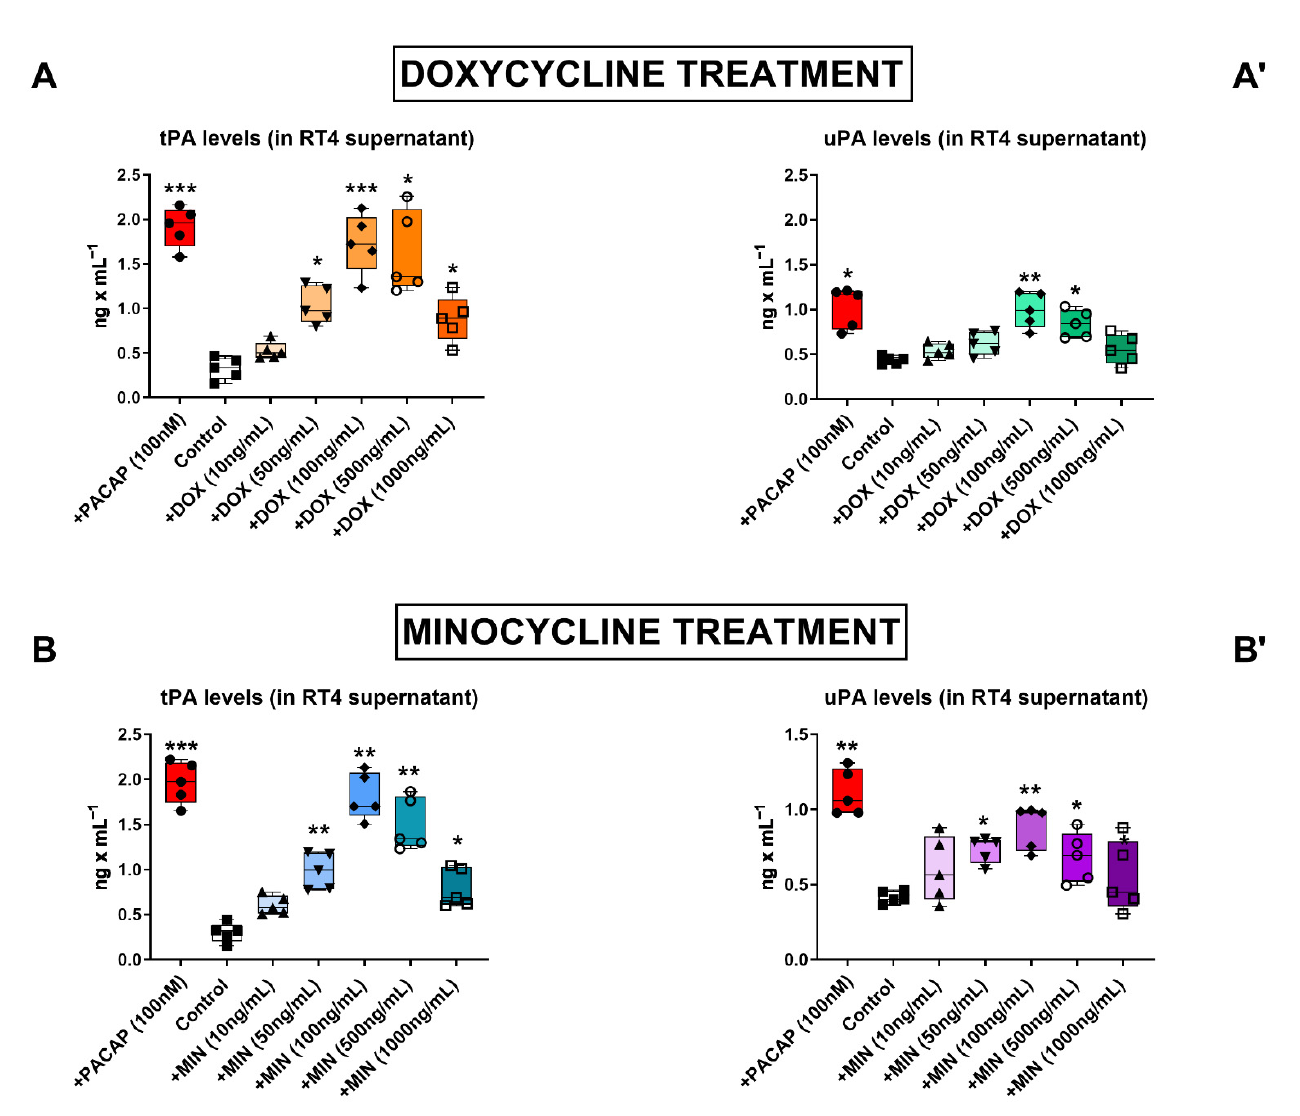
Figure 1. Dose–response effect of doxycycline and minocycline on tPA and uPA secretion in RT4 cells. ( A , B ) Levels of secreted tPA or uPA in the supernatant of RT4 cells treated with either doxycycline ( A , A’ ) or minocycline ( B , B’ ). RT4 cells were treated with the indicated treatments for 24 h. Cell supernatants were harvested and the concentration of tPA and uPA were determined by ELISA. Data shown are the result of two independent experiments using five different batches of cells (n = 5). * p < 0.05, ** p < 0.01 or *** p < 0.001, as determined by ANOVA followed by Dunnett’s post-hoc test.